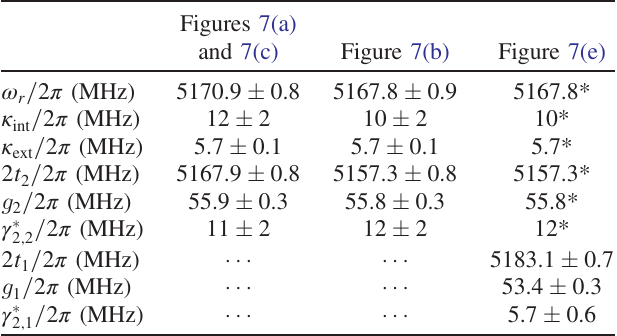
TABLE II. Extracted values from the data shown in Fig. 7 by fitting the line traces as described in the text. For Figs. 7(a) and 7(c), the line trace at δ 2 = 2 π ¼ 0 . 2 GHz is used. For extracting the values indicated as Fig. 7(b), we use the data in this figure at detuning δ 1 = 2 π ¼ − 2 . 9 GHz, leftmost line trace. The extracted parameters indicated as Fig. 7(e) are used to extract the DQD 1 parameters with the resonator and DQD 2 parameters fixed (indicated by